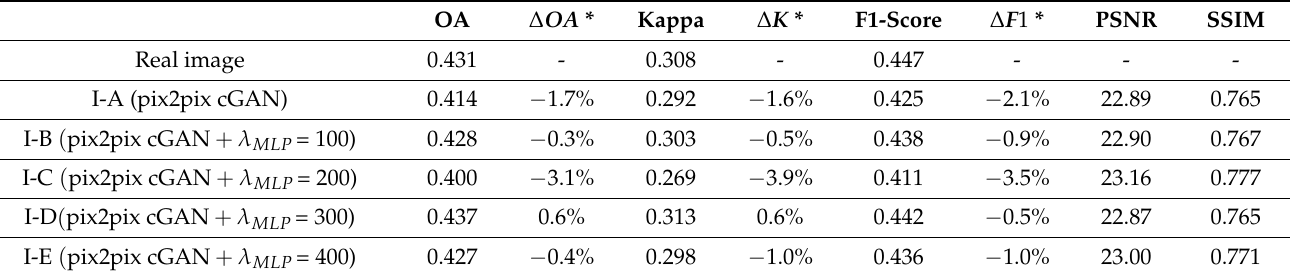
Table 5. Metrics for evaluation for the semantic segmentation and similarity between the real and synthetic images generated using different methods.